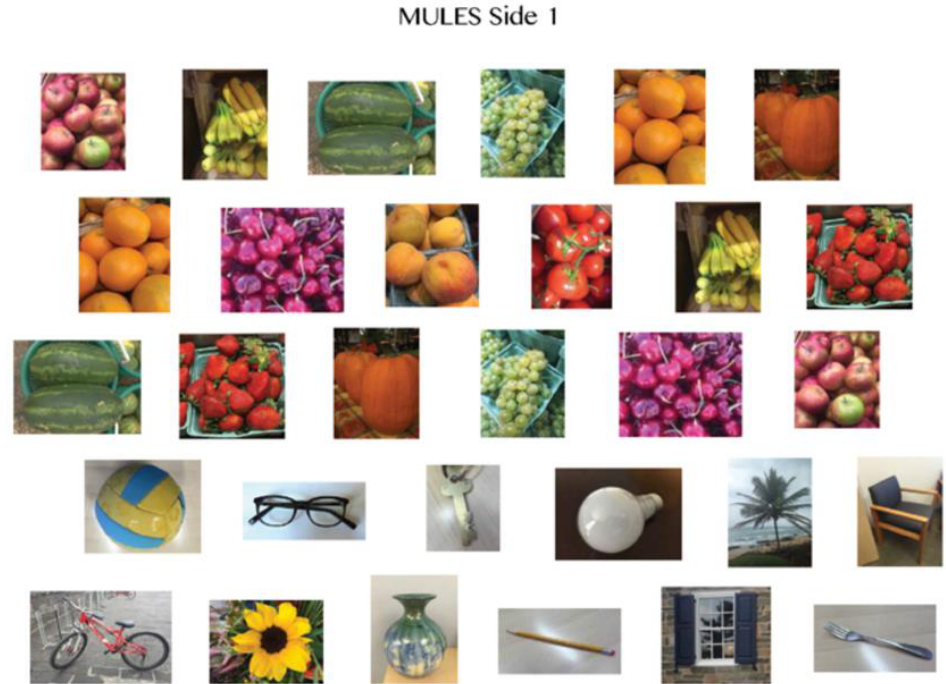
Figure 1. Side 1 of the Mobile Universal Lexicon Evaluation System (MULES), rapid picture naming test (MULES Test ©